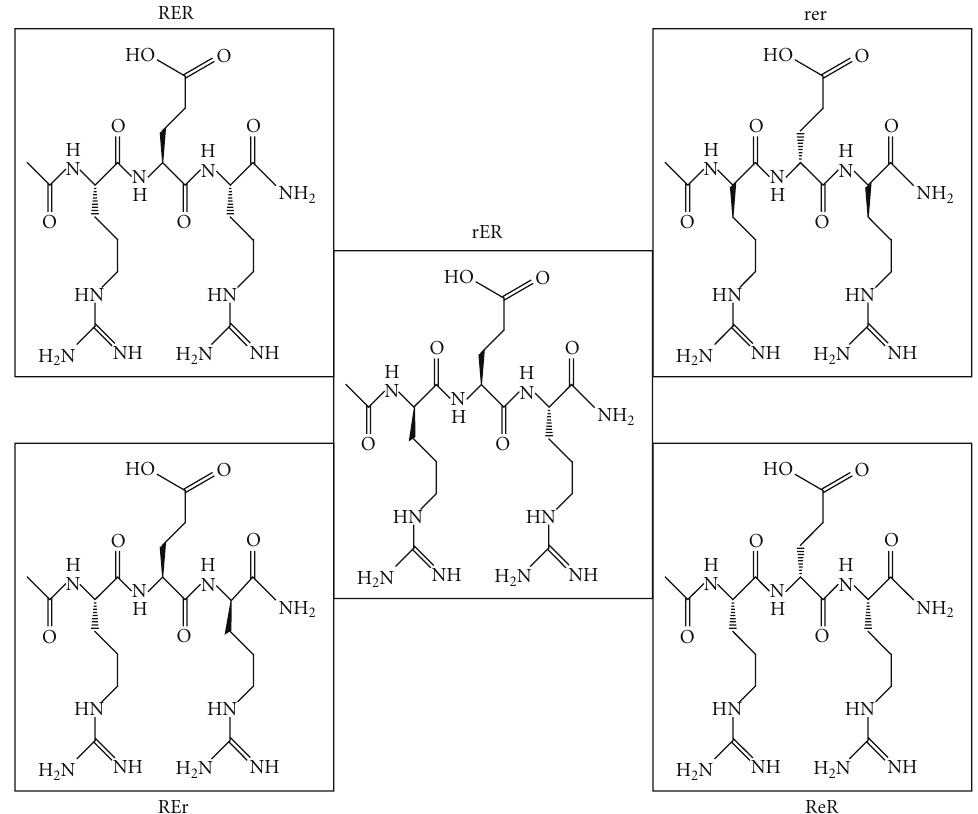
Figure 4: Structure of D/L tripeptides included in the